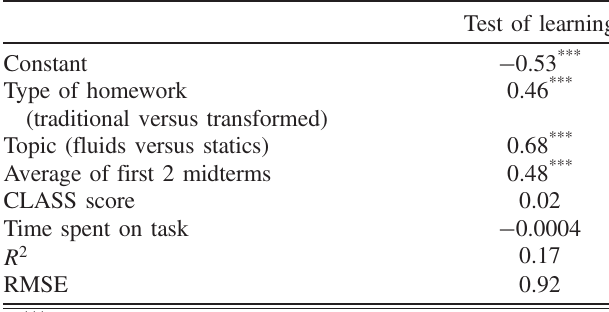
TABLE III. Standardized coefficients for linear regression model predicting students ’ performance on the test of learning. Model controls for class topic (fluids versus statics), self-reported time spent on task, and two measures of background proficiency (scores on midterms and on the Colorado Learning Attitudes about Science Survey, CLASS